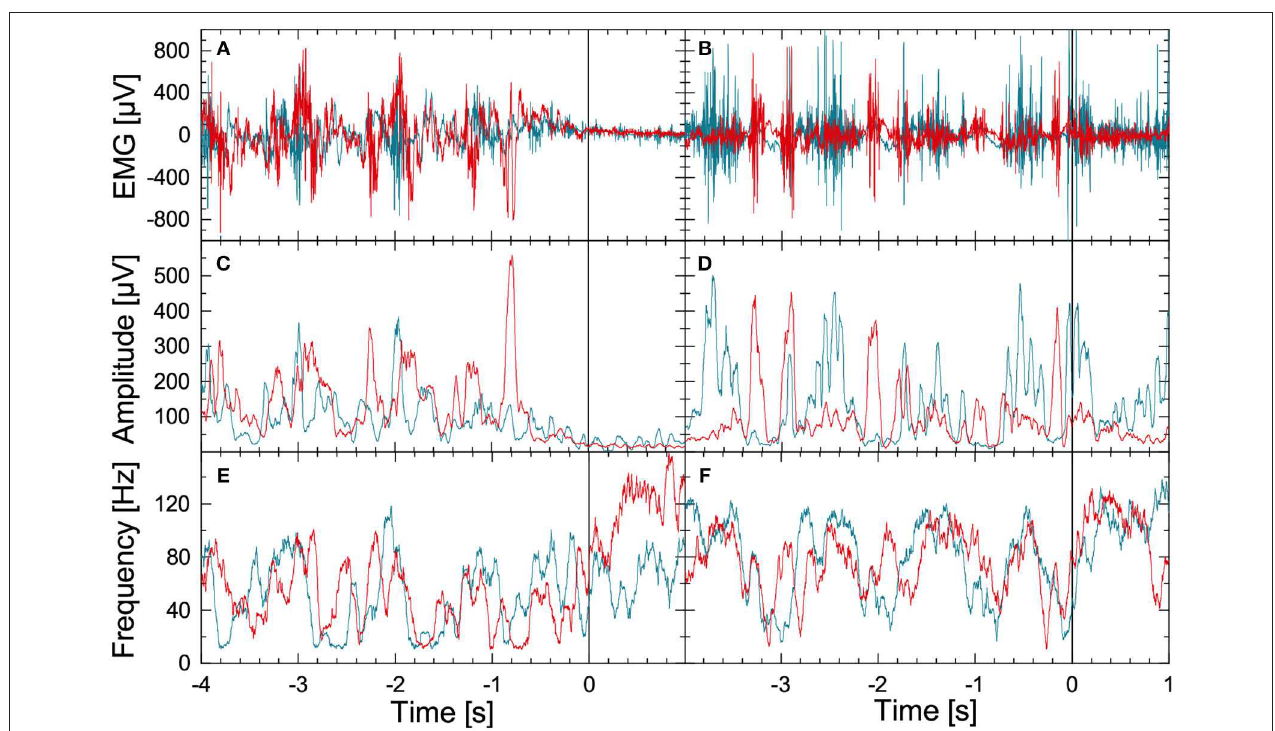
FIGURE 1 | (Color online) Illustration of EMG data preprocessing as optimized for the data recorded during FOG-provoking experiments. (A) Raw EMG signals recorded with electrode pairs for the right musculus gastrocnemius (blue) and the right musculus tibialis anterior (red) in a PD subject during normal walking (time: –4 to 0 s) and during a commanded stop (time: 0 to +1 s). A Hilbert transform and the analytic signal approach were applied to these data to derive (B) instantaneous amplitude, and (C) instantaneous frequency series. (D–F) Raw EMG and corresponding instantaneous amplitude and frequency series for a PD subject during walking (time: –4 to 0 s) and during FOG (time: 0 to +1 s). Note the significant difference in EMG between the stop and the FOG